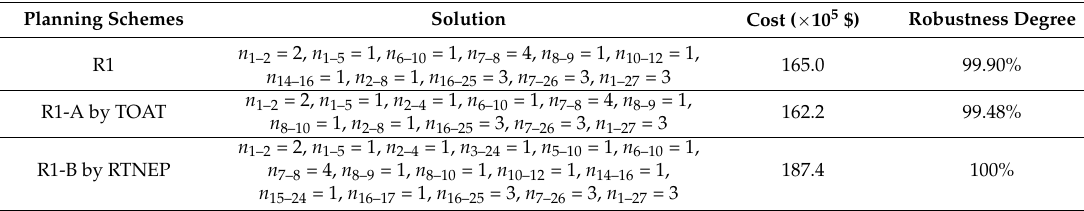
Table 2. Robustness analysis.